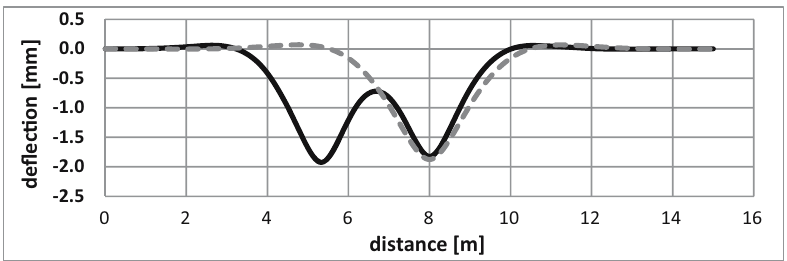
Figure 7: Calculated de fl ection lines for the track as the fi rst stage of the model. The data are given in Table 4, and the speed is 200 km/h. De fl ection under 1st axle is 1.74 mm, de fl ection under 2nd axle is 1.88 mm, and in the case of one axle, the de fl ection is 1.81